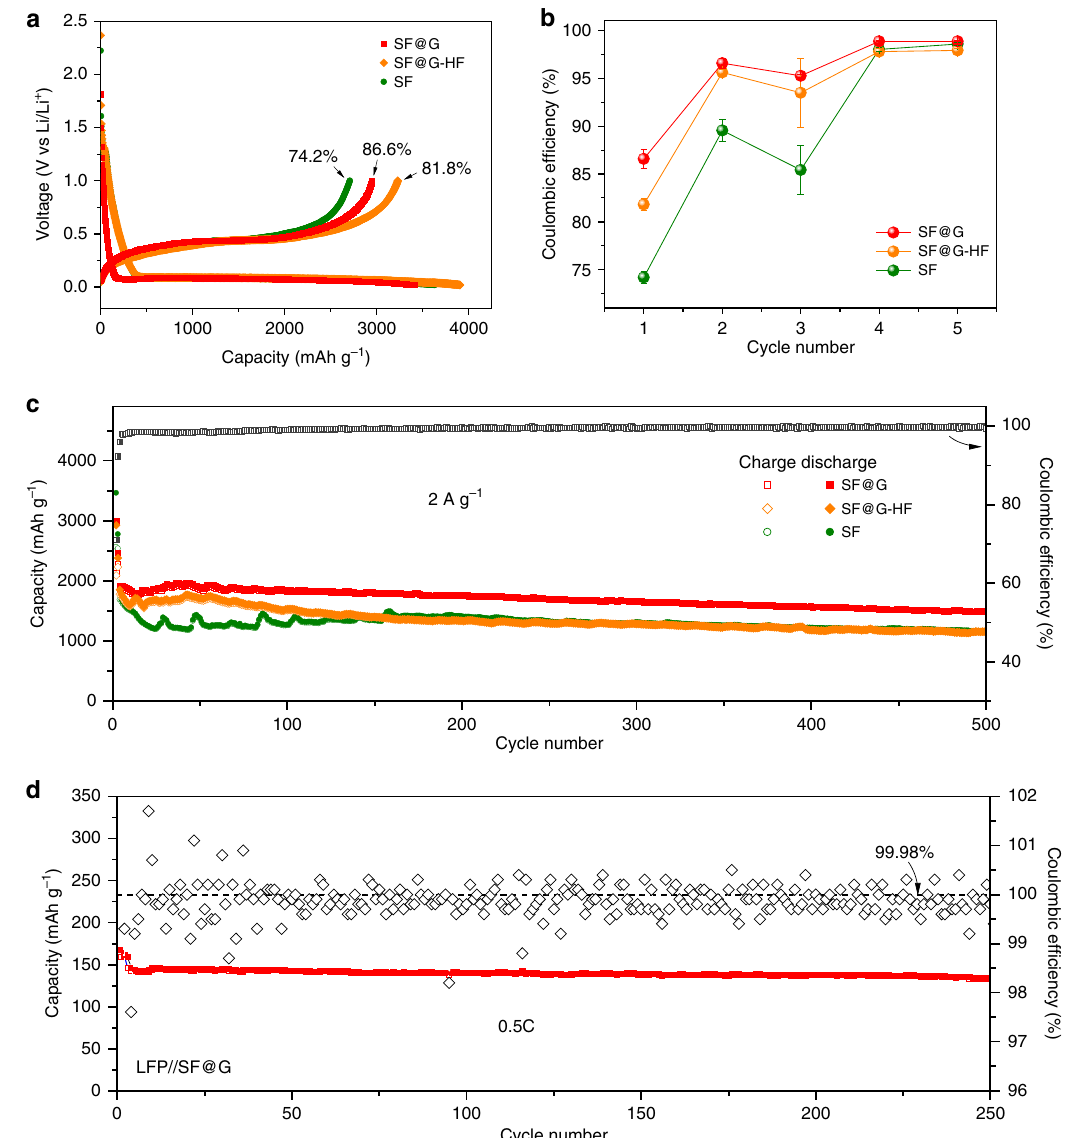
Fig. 3 Electrochemical characterization of SF@G upon cycling. a Charge – discharge pro fi les of SF@G, SF@G-HF, and SF at 0.2 A g − 1 for the fi rst cycle. b Coulombic ef fi ciency of SF@G, SF@G-HF, and SF for initial fi ve cycles. c Cycling performance of the SF@G and control electrodes over 500 cycles at 0.2 A g − 1 for initial two cycles and 2 A g − 1 for subsequent cycles. The Coulombic ef fi ciency of SF@G is plotted on the secondary y-axis. d Reversible capacity and Coulombic ef fi ciency vs. cycle plots of the LFP//SF@G full cell with SF@G as the anode and a commercial lithium iron phosphate (LFP) as